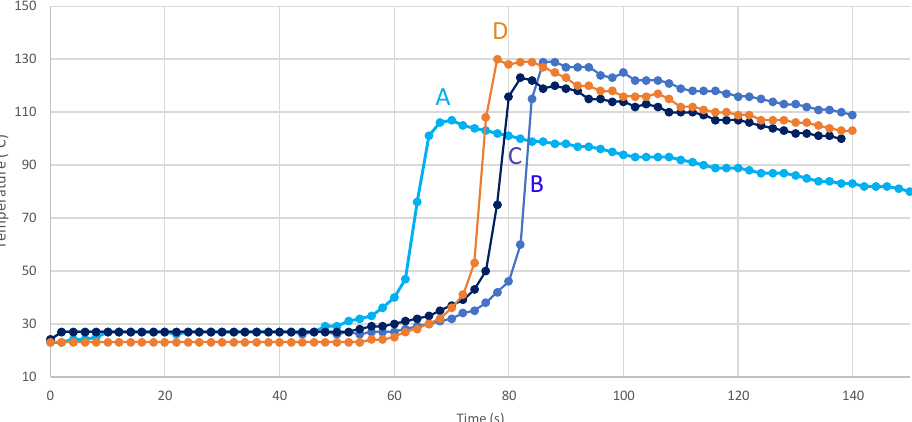
Figure 7. Optical pyrometric measurements (temperature vs. time after mixing; 4 mm thick sample) under air for the BM resin for Redox FRP using a T4epa/Iod (1.5%/1.5% w/w ) RIS for different storage time: ( A ) fresh cartridges; ( B ) aging of the two cartridges for 7 days @50 ◦ C; ( C ) aging of the two cartridges for 14 days @50 ◦ C; ( D ) aging of the two cartridges for 28 days @RT.